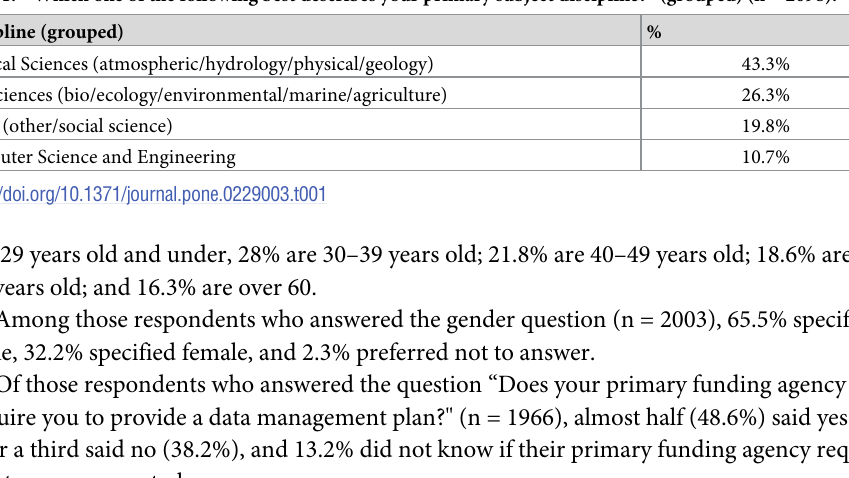
PLOS ONE | https://doi.org/10.1371/journal.pone.0229003 March 11,